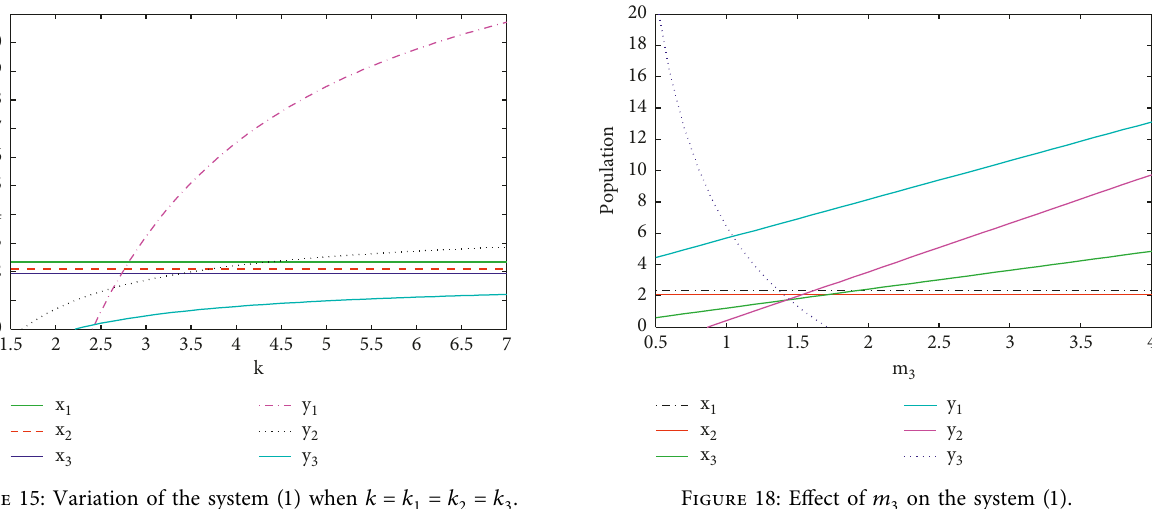
on the system (1). 3